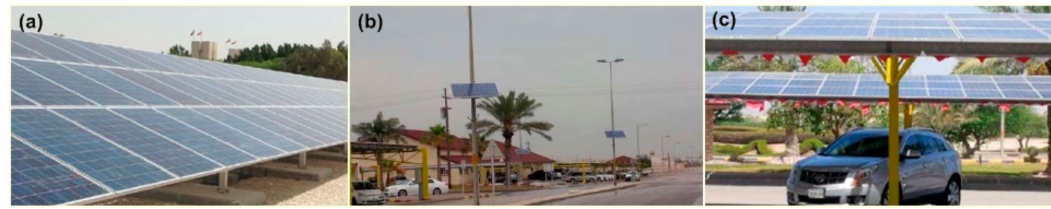
Figure 3. Selections of PV installations in Bahrain, where: ( a ) 0.5 MW polycrystalline solar PV installed at the University of Bahrain; ( b ) PV panels mounted on street lights in Alwali town; and ( c ) PV panels mounted on carports in Alwali town. Adapted from